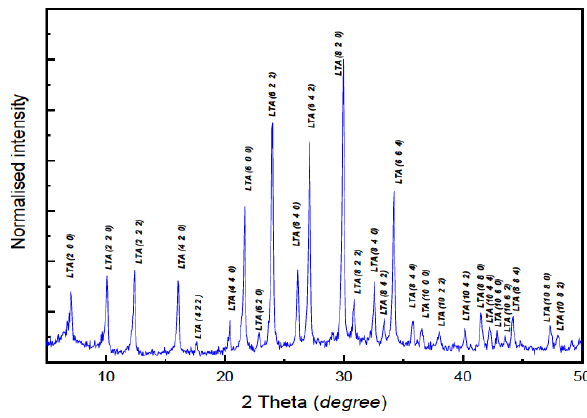
Figure 1: XRD powder diffraction pattern for as-synthesized LTA zeolite under the proposed conditions.